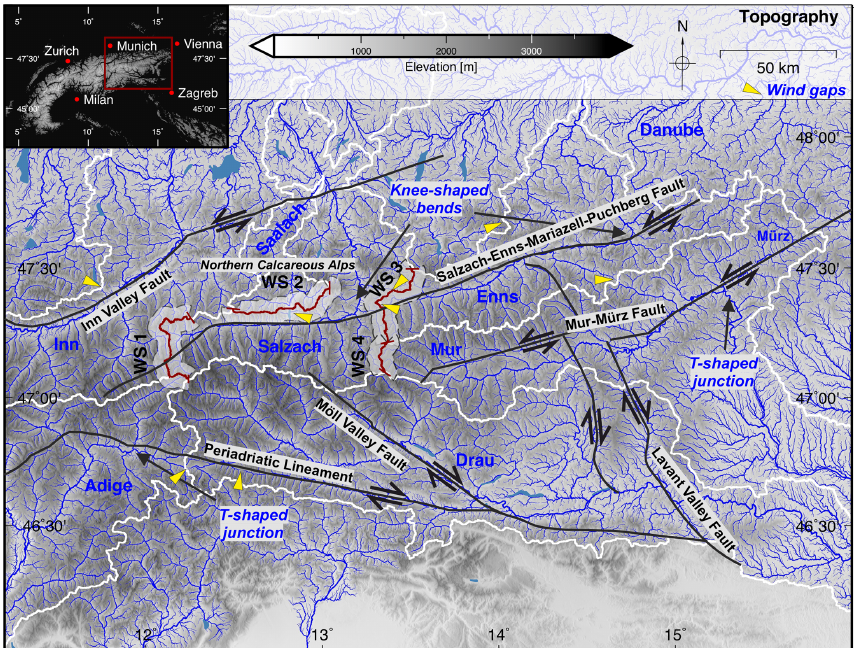
Figure 1. Topographic map of the study area and the drainage pattern of the Eastern Alps. The inset shows the position of the study area within the European Alps. Blue lines indicate the drainage pattern, and the line width is proportional to the log 10 of the contributing drainage area. Drainage divides are shown by thick white lines. Major faults are indicated by solid black lines, and the direction of motion is shown by arrows. The red line and the grey contours indicate the course of the swath profiles shown in Fig. 3. Yellow triangles illustrate the occurrence of prominent wind